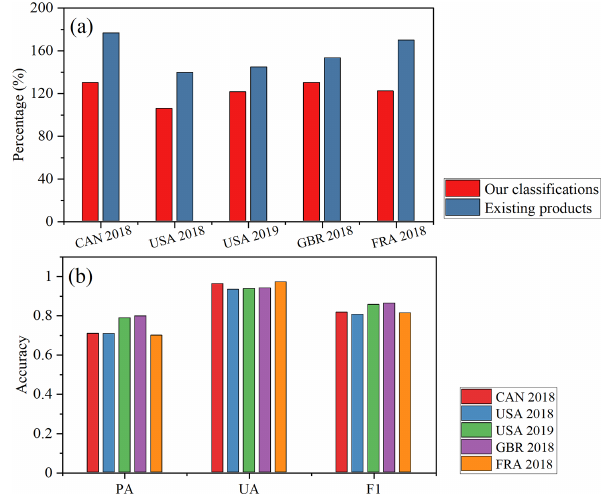
Figure 8. Classification validation results. (a) Percentage of rape- seed areas based on FAO statistics classified as such in existing products and our rapeseed map database. (b) Accuracy of our clas- sifications in four countries (Canada, USA, GBR, and France) us- ing existing products as a reference. UA, user’s accuracy; PA, pro- ducer’s accuracy; F1, F1